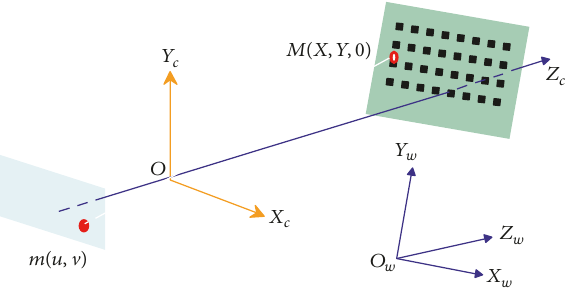
Figure 9: The space map of Zhang Zhengyou’s plane calibration.